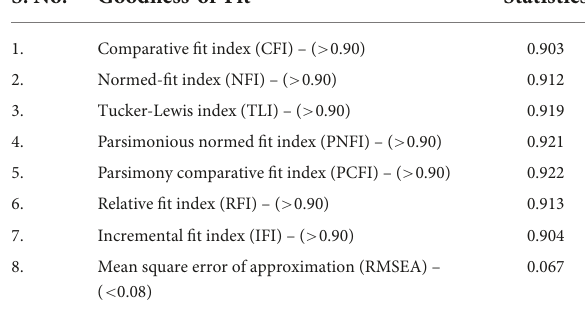
TABLE 4 Goodness of fit